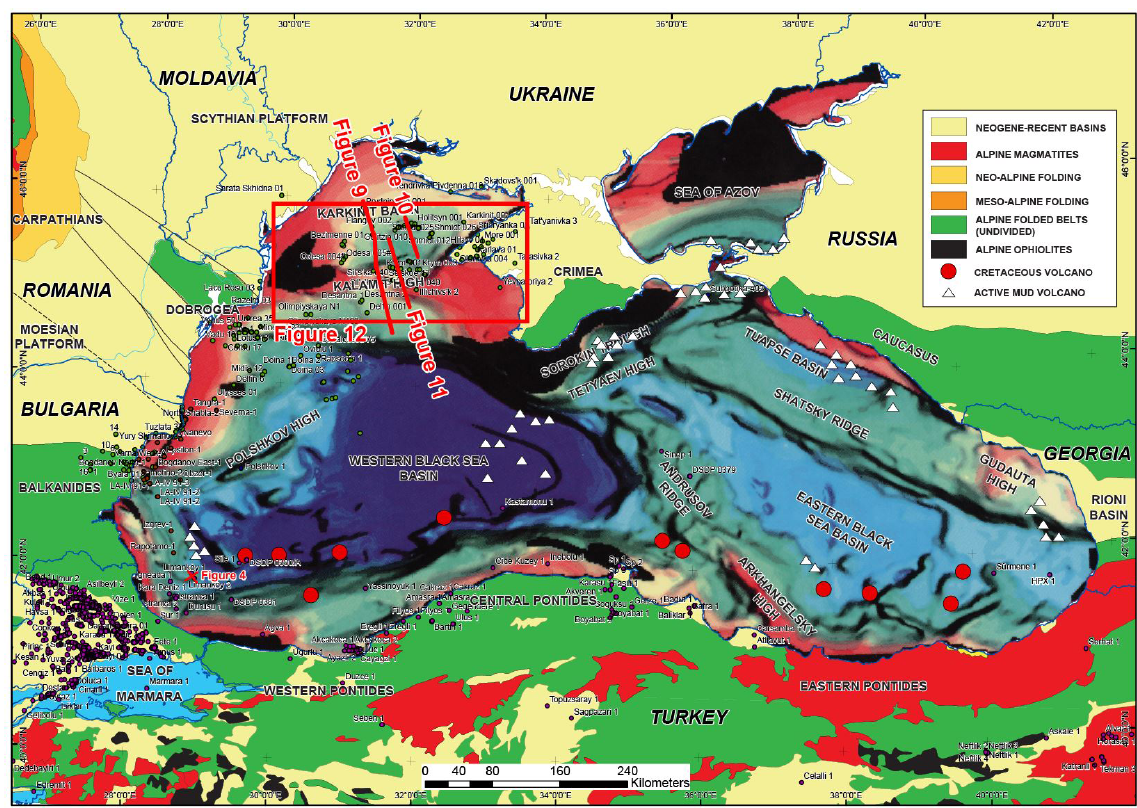
Figure 8. Simplified structural map of the Black Sea modified from Tari and Simmons (2018). Location is shown in Fig. 1. Within the Black Sea itself, the depth-to-break-up unconformity is shown, cold colors indicating greater depth, adapted from Robinson (1997). Black lines between the Carpathians and the Black Sea correspond to major faults pre-dating the opening of the Black Sea (Krezsek et al., 2017). White triangles represent offshore mud volcanoes and red dots represent Cretaceous paleo-volcanoes (Nikishin et al., 2015a). The locations of a depth-converted, regional seismic line (Fig. 10), two vintage seismic profiles (Figs. 11 and 12), and a Maykop (Oligocene to lower Miocene) isopach map (Fig. 13) are shown by red